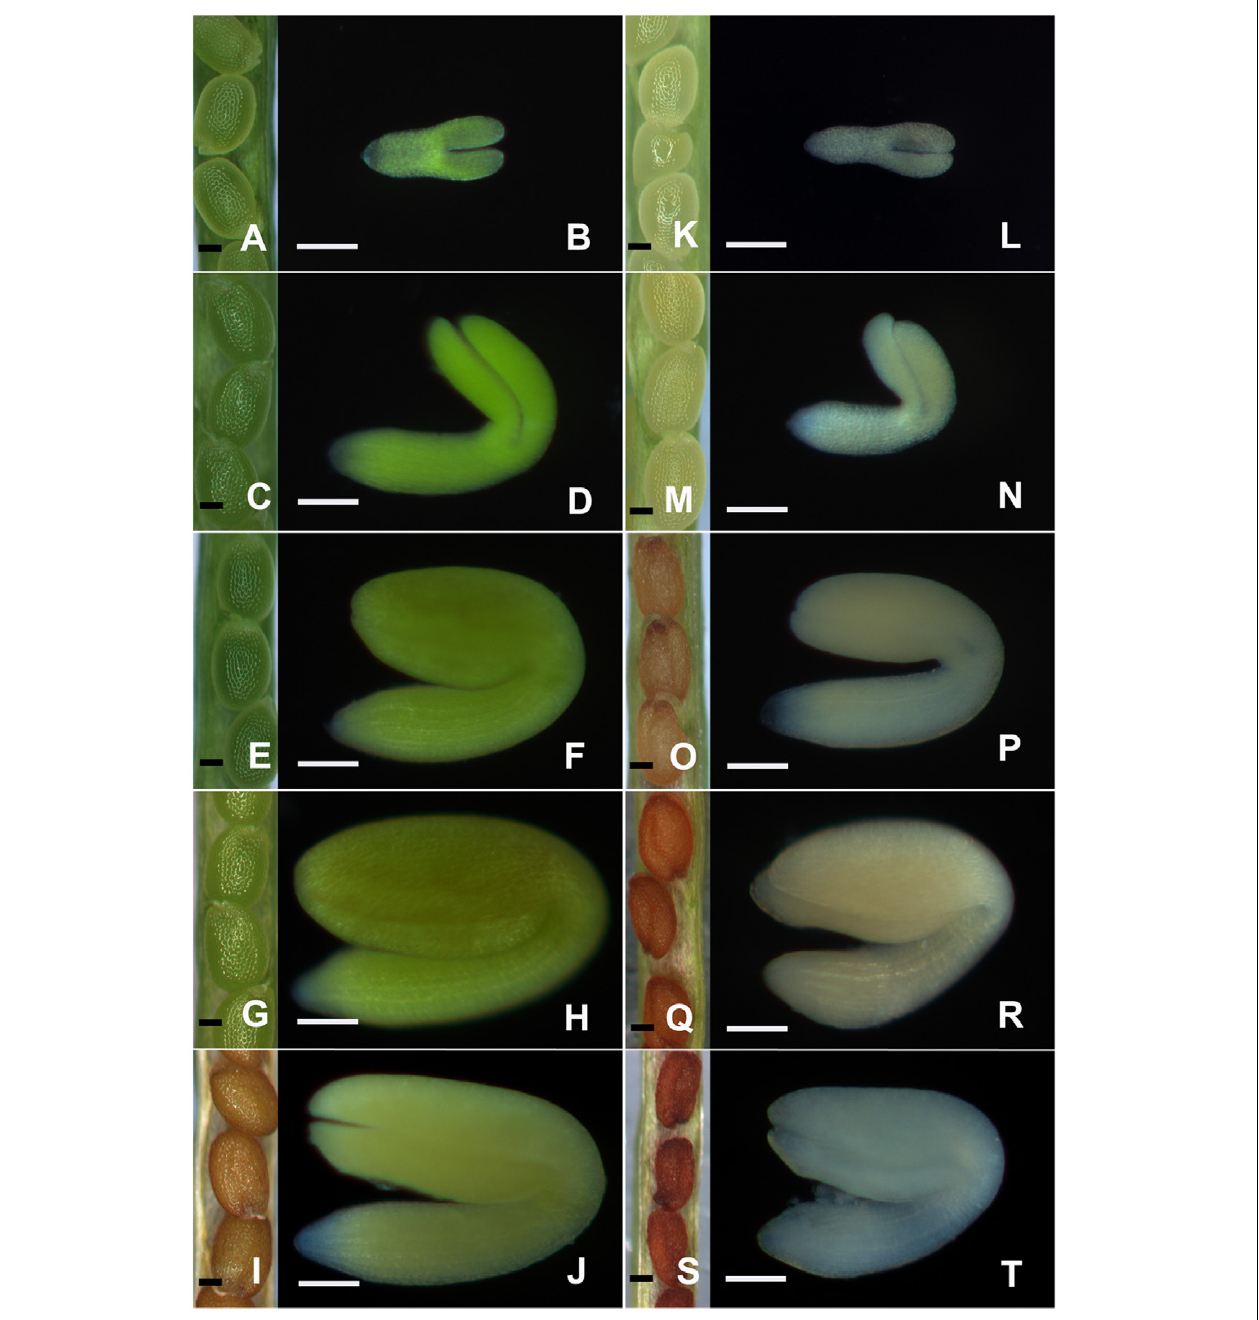
FIGURE 2 | The morphology of ovules/embryos during embryo development. Both the control (A–J) and treated (K–T) ovules/embryos were analyzed with a Zeiss stereomicroscope when they were grown for 6 (A,B,K,L) , 8 (C,D,M,N) , 10 (E,F,O,P) , 12 (G,H,Q,R) , and 14 (I,J,S,T) DAP, respectively. Bar = 100 µ